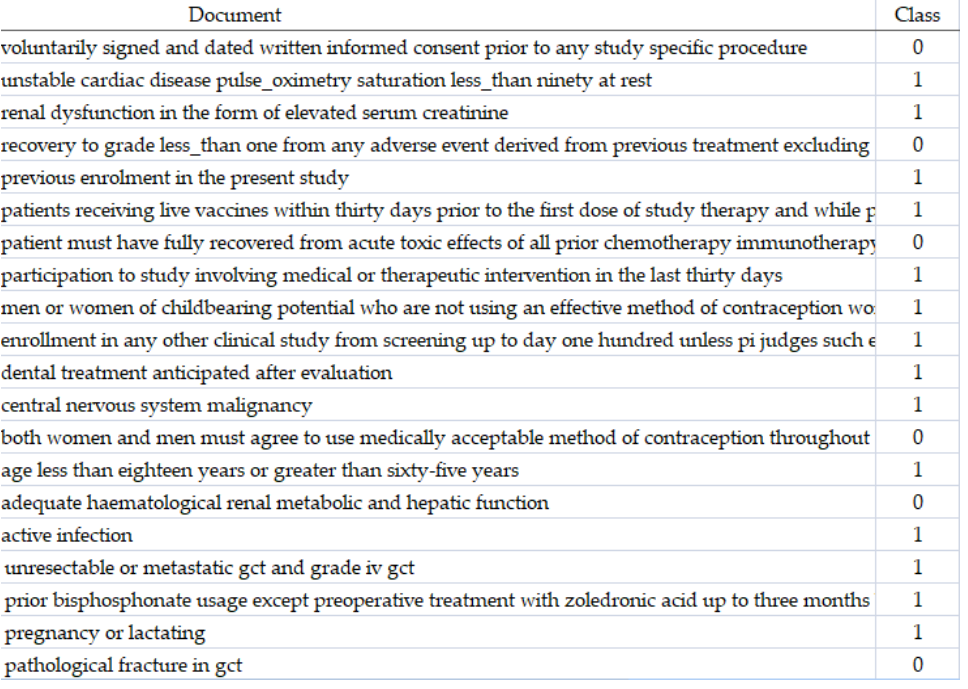
Table 1. Overall results of the validation set for all classifiers using a dataset of 10 6 samples.